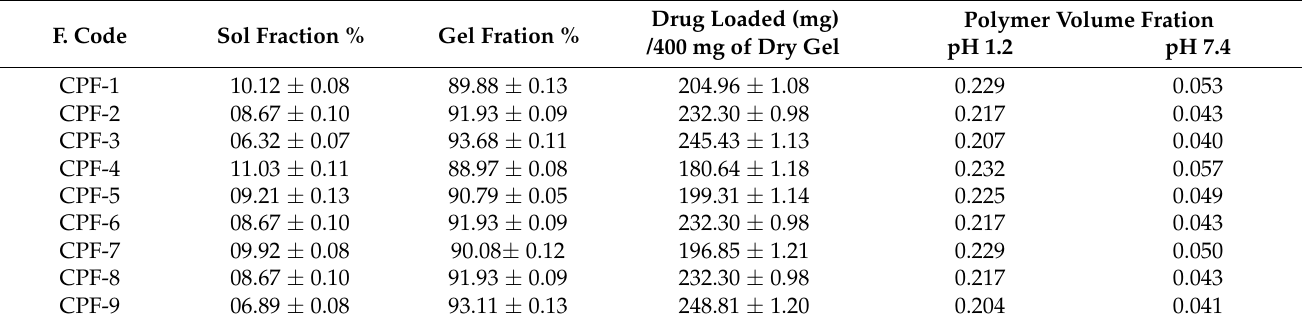
Table 1. Sol-gel analysis, drug loading, and polymer volume fraction of CP/SpScPAA